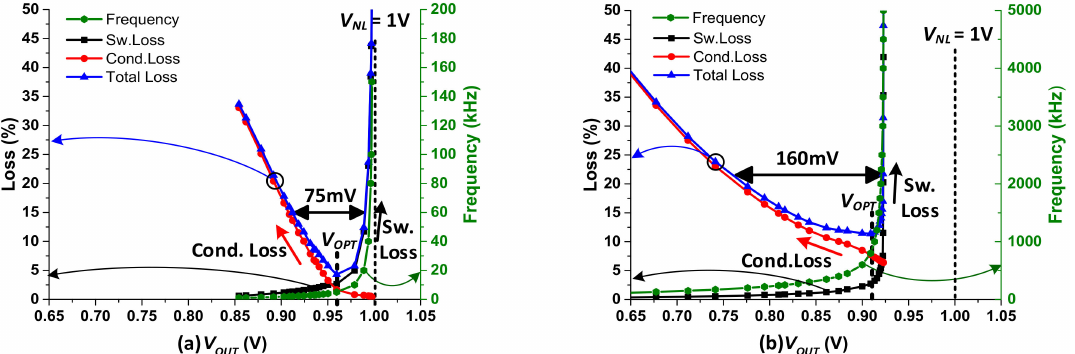
Figure 2. Loss contribution in single stage 2:1 SC converter from V IN = 2.0 V ( a ) Light load (500 nA). ( b ) Heavy load (100 µ